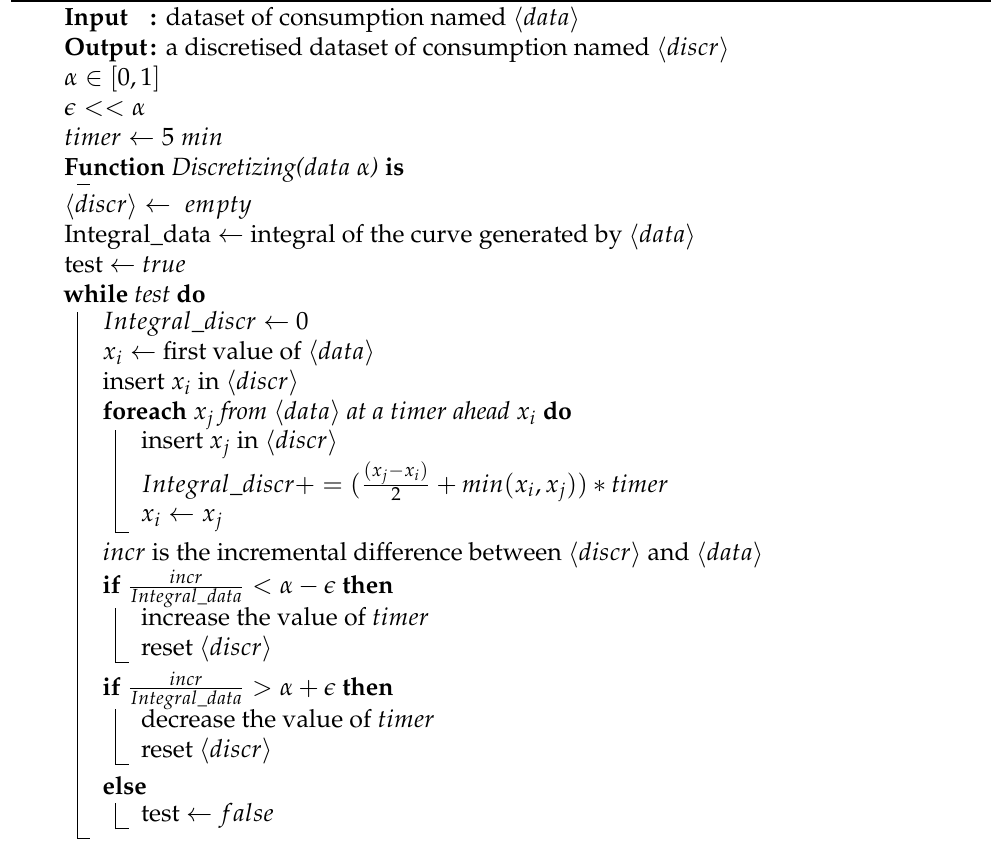
Algorithm 1: Discr.